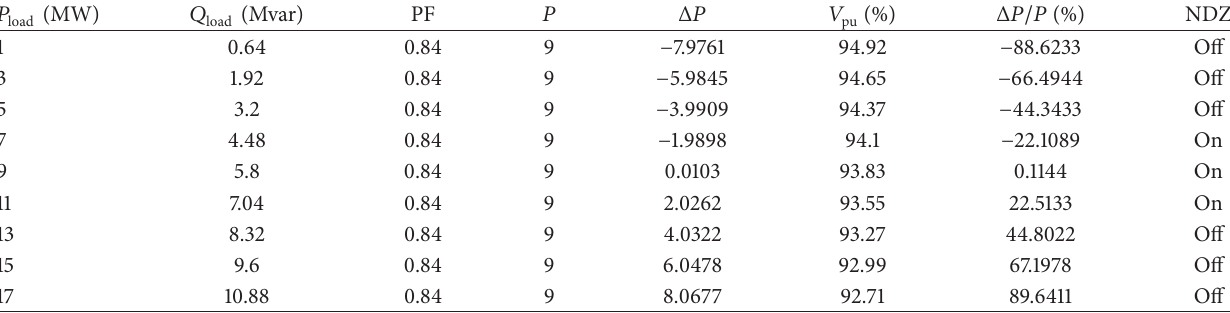
Table 3: The change of load affecting Δ P